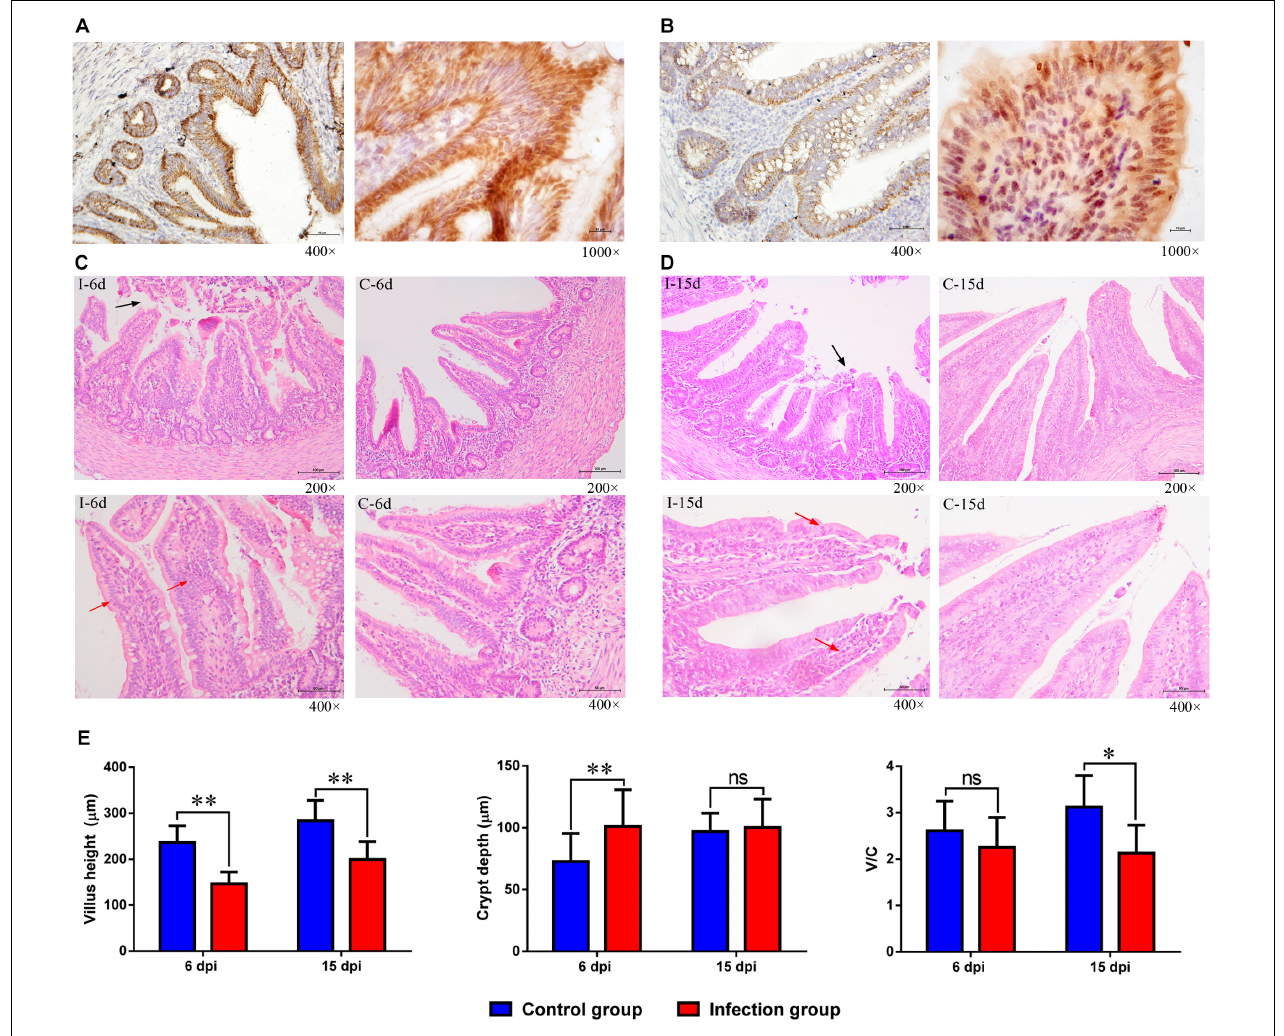
FIGURE 7 | The location of D-GPV antigen and histopathological changes in caecum at 6 dpi and 15 dpi. (A) Positive virus signals were detected on the surface of epithelium cells and glandular epithelial cells at 6 dpi. (B) Positive virus signals were mainly detected in basal base and basement membrane of cells at 15 dpi. (C,D) Histological features in the D-GPV infection group (i) and control group (c) are shown with hematoxylin and eosin staining at 6 dpi and 15 dpi. Necrosis and abscission of mucous epithelial cells are indicated with the black arrow. Proliferation of lymphocytes in laminae propria is indicated with the red arrow. (E) Villus height, crypt depth and the ration of villus height to crypt depth (V/C) in caeca of proximal ileum. Values were means ± standard deviation of three independent experiments ( ∗ P < 0.05, ∗∗ P < 0.01 by post hoc ANOVA), and ns meant no significant